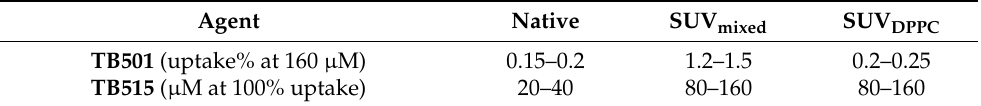
Table 3. Characterization of the cellular uptake rate of two antitubercular candidates on MonoMac-6 human monocytic cells measured by flow cytometry (mean fluorescence intensity signal; FITC LP505; BP 530/30 in duplicates): uptake% at 160 µ M agent concentration for TB501, and minimal agent concentrations ( µ M) of 100% uptake rate for TB515. For native agents and liposomal formulations (in SUV mixed and SUV DPPC ). (Concentration interval means the 100% uptake rate was reached between these two values in the serial dilutions.)